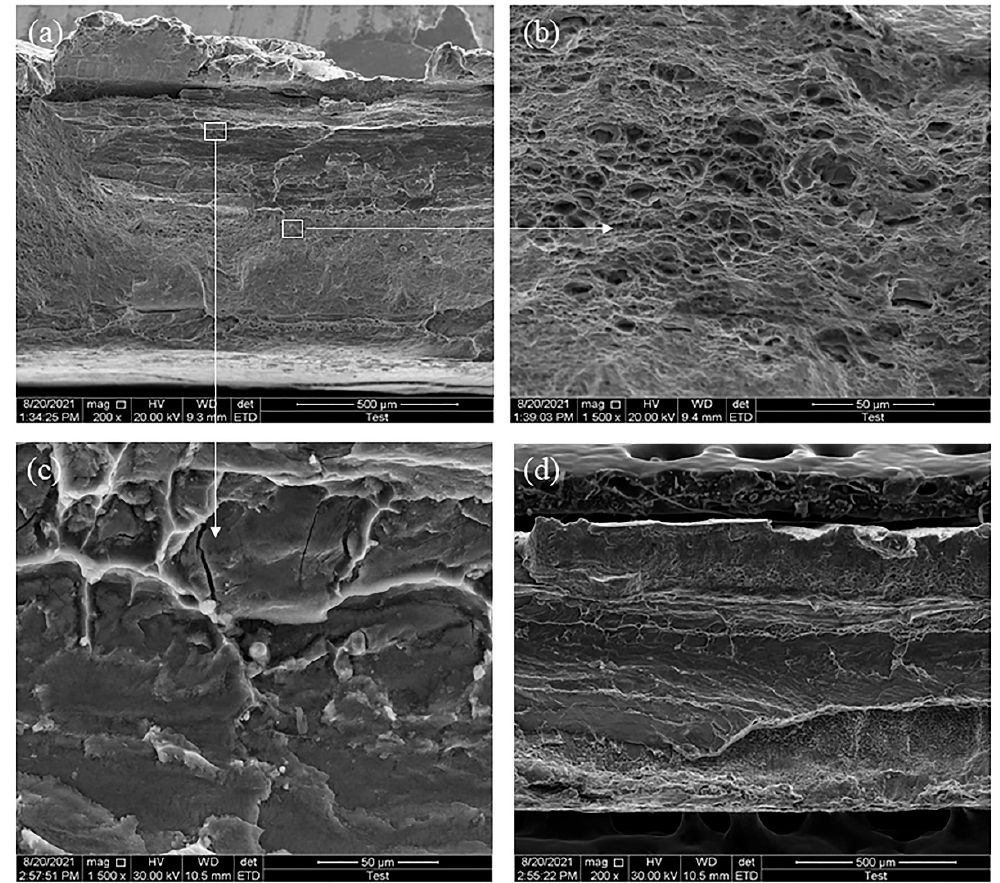
Figure 15. SEM photos of tensile fracture ( a ) fracture SEM picture under HRS-FSW. ( b ) partial enlargement in Figure 15.( a ). ( c ) partial enlargement in Figure 15.( a ). ( d ) fracture SEM picture under ultra-HRS-FSW.